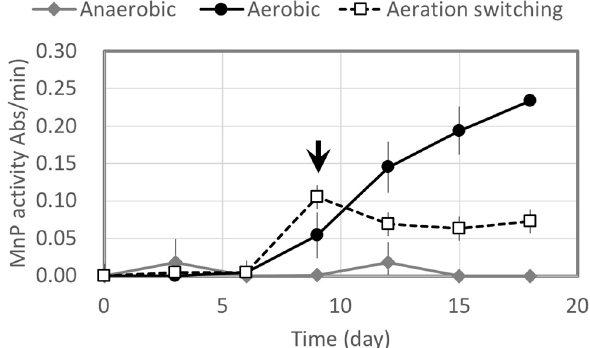
Figure 2. Relative manganese peroxidase (MnP) activities by B. adusta IWA5b under three kinds of aeration conditions: aerobic condition, anaerobic condition, and switching aeration (at arrow).